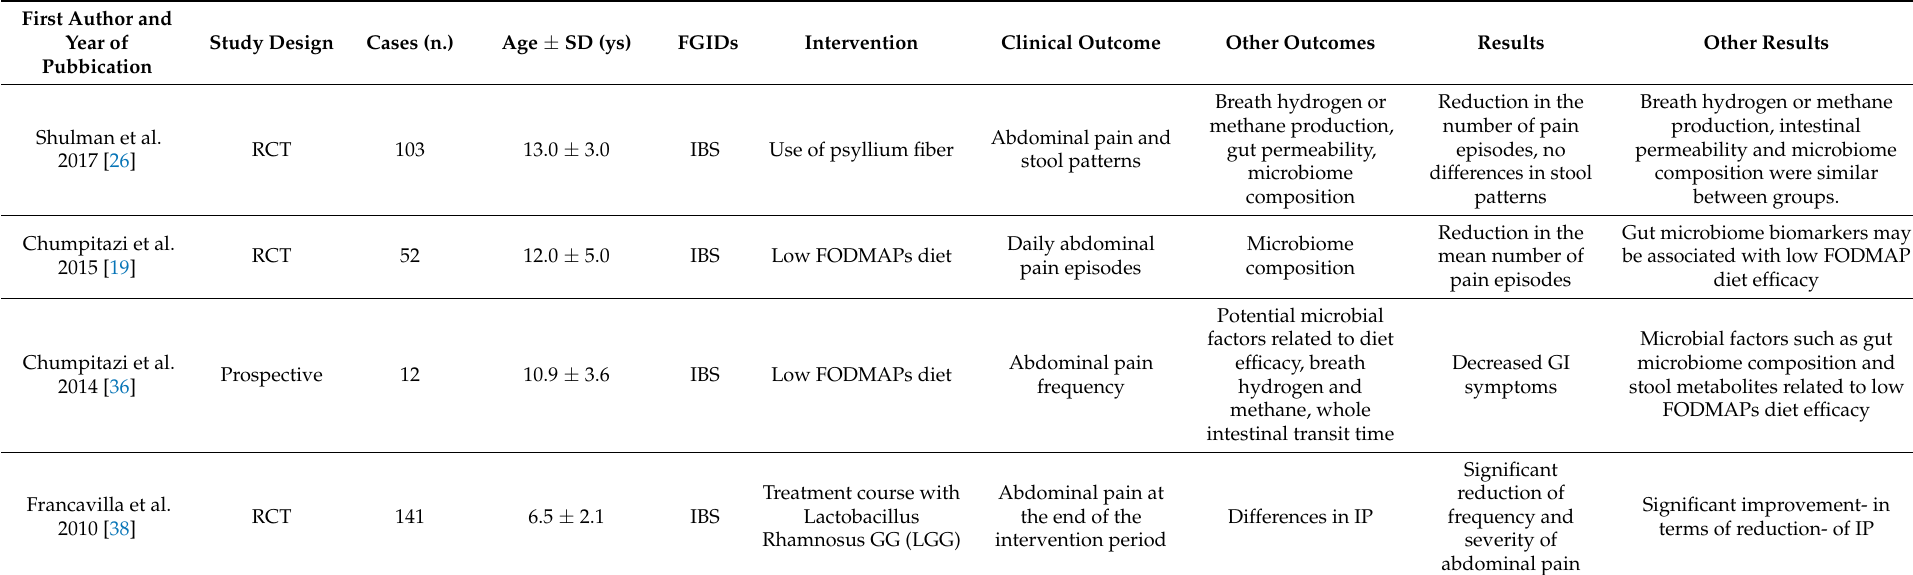
Table 1. Clinical trials included in the review, main methods, results and